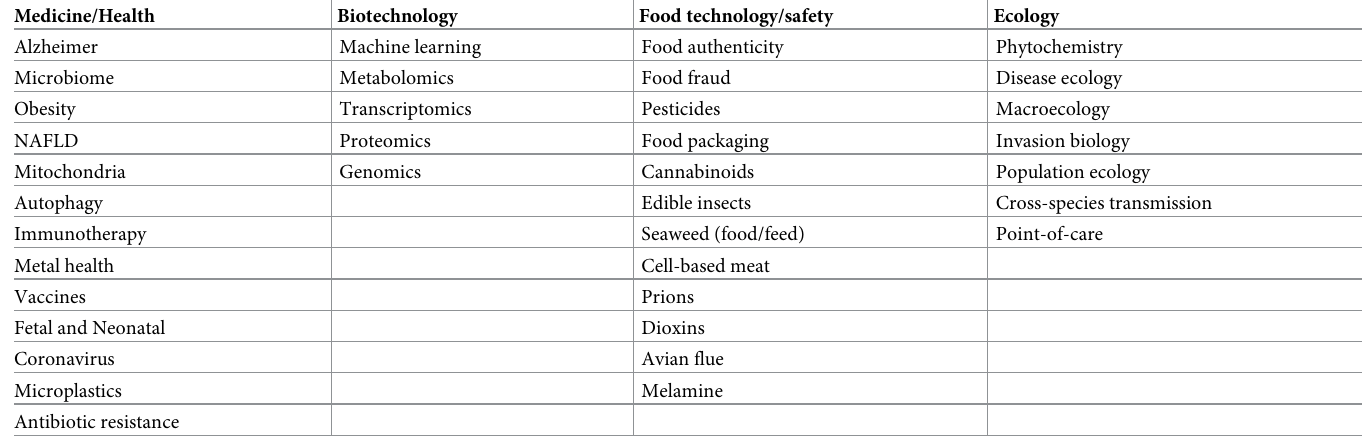
Table 1. Investigated fields in the life sciences. The 37 fields for which GGTs were calculated and inflation adjusted trend analysis performed. Fields are classified into different sections. The classification used is non-stringent and merely used to reflect the potential of GGT over a variety of disciplines in the life-sciences.